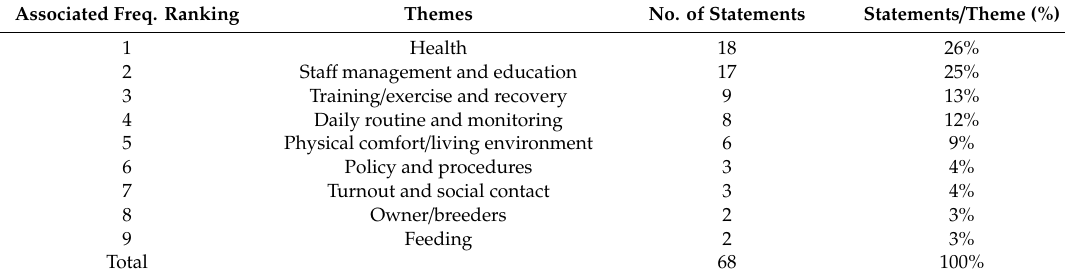
Table 1. Number of statements per theme and associated frequency ranking. Associated Freq.